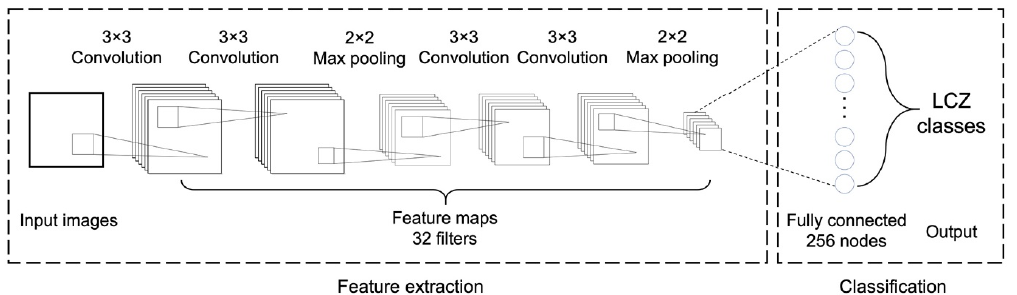
Figure 3. The structure of the convolutional neural network (CNN) model in this study.